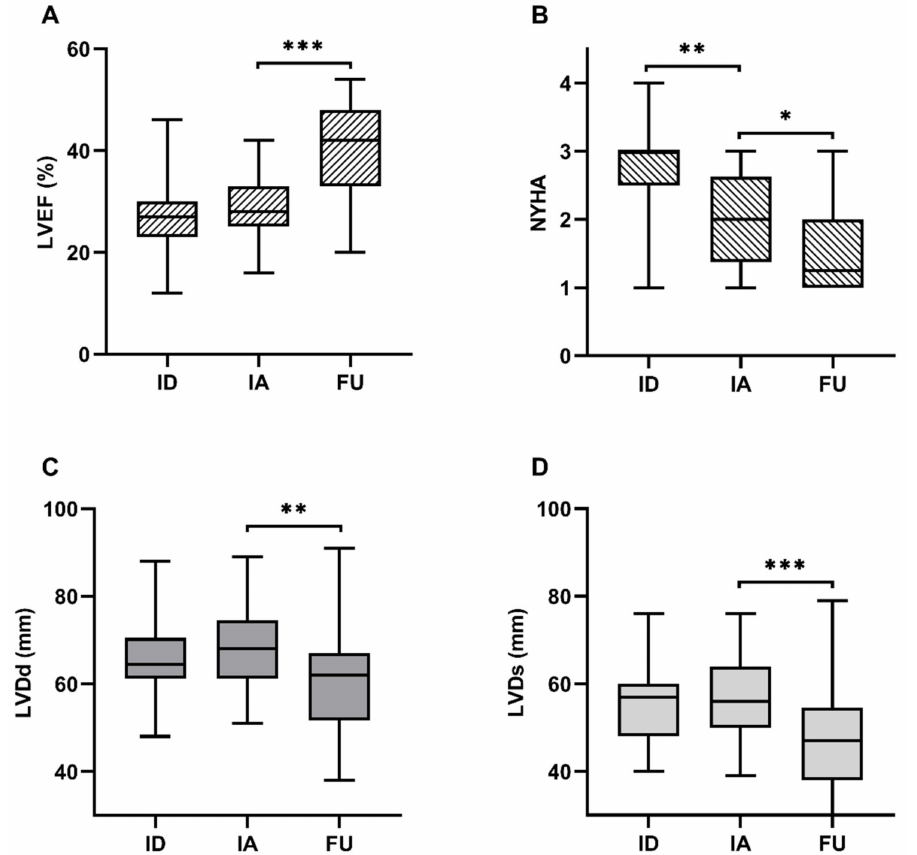
Figure 2. Course of LVEF, NYHA and LV diameters. Course of ( A ) LVEF, ( B ) NYHA, LVDd ( C ) and LVDs ( D ) from initial diagnosis (ID), before immunoadsorption (IA) and at long-term follow-up (FU). (Boxes represent median ± IQR, whiskers represent minimum and maximum values, *** p < 0.0001, ** p < 0.005, * p <